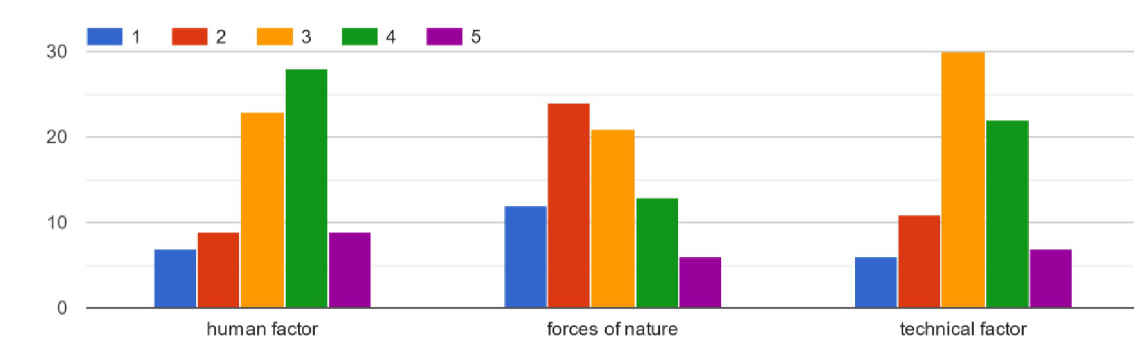
Fig 3. The most common causes of measuring equipment failures assessed from 1—the least common to 5—the most